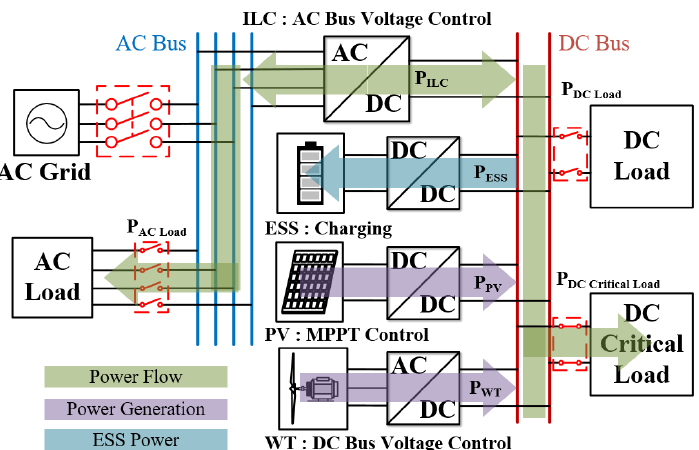
Figure 14. Mode 5: Cut-off load operation.